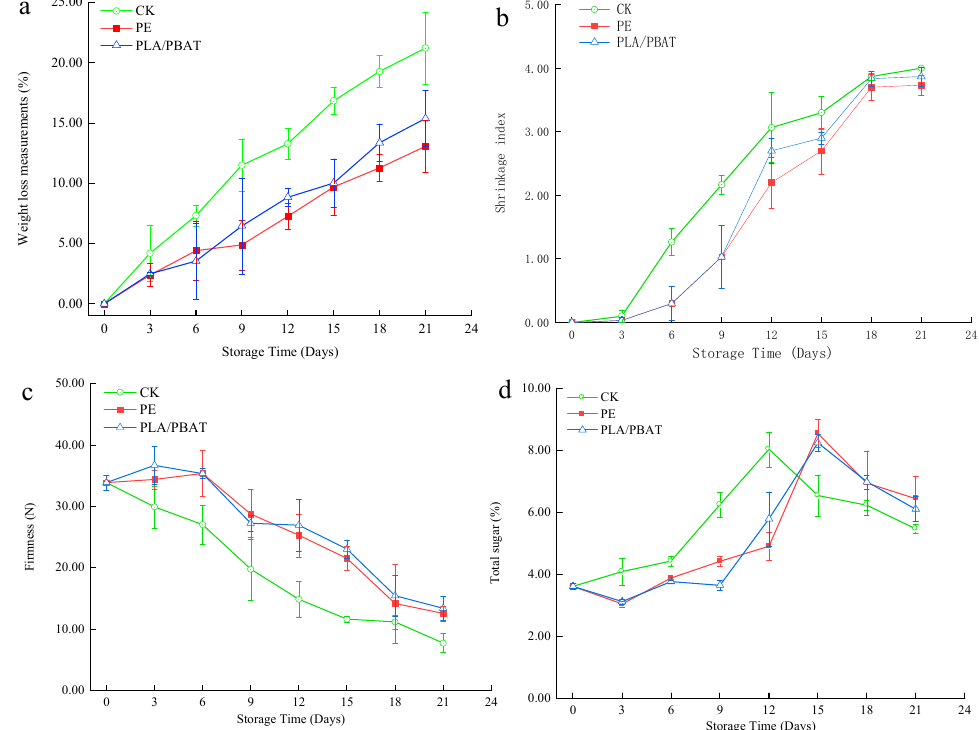
Figure 1. Effect of PLA/PBAT antibacterial packaging film on the ( a ) weight loss, ( b ) shrinkage index, ( c ) firmness, and ( d ) total sugar of passion fruit during storage times (t = 8). PLA: poly(lactic acid); PBAT: poly(butylene adipate-co-terephthalate); CK: unpackaged; PE: polyethylene.